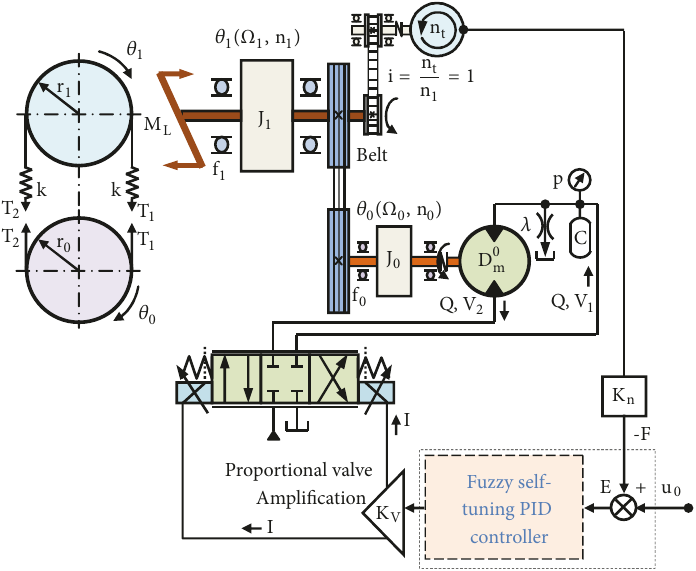
Figure 4: Mathematical model.